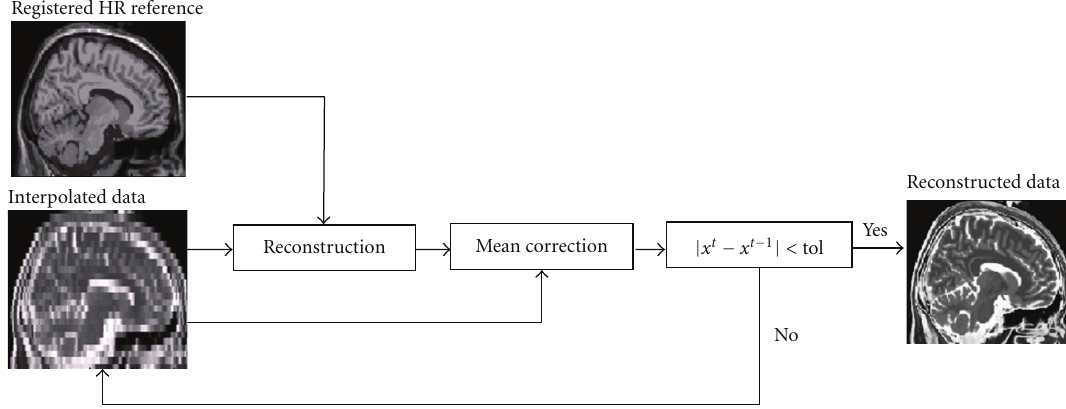
Figure 1: Block diagram of the proposed method. The registered HR reference data is used reconstruct the LR data iteratively until no significant di ff erence is found between two consecutive